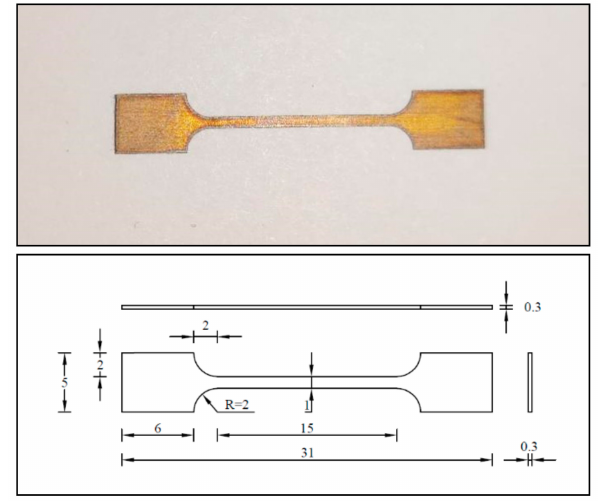
Figure 1. SMA dog bone sheet specimen and dimensions (Unit: